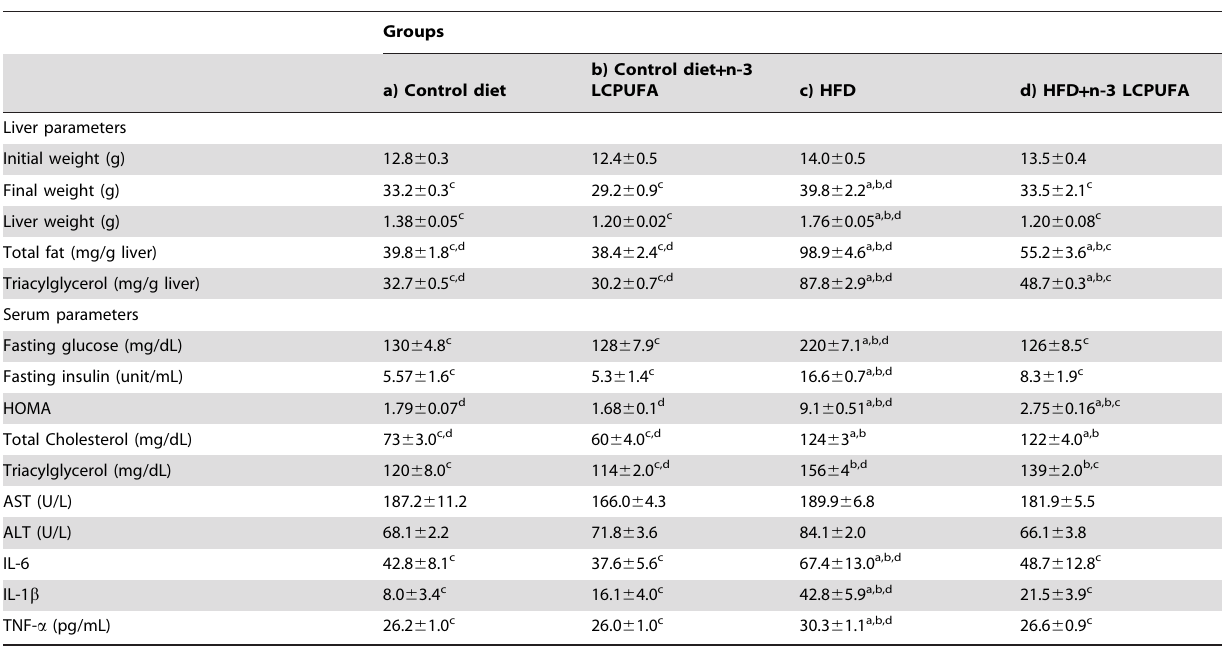
Body weight, liver weight, and biochemical variables in control and high fat diet (HFD) fed mice subjected to n-3 long-chain polyunsaturated fatty acid (n-3 LCPUFA) supplementation. Values represent means 6 SEM for 14 mice per experimental group. Significant differences between the groups are indicated by the letters identifying each group ( P , 0.05; one-way ANOVA and the Newman-Keuls’ test).